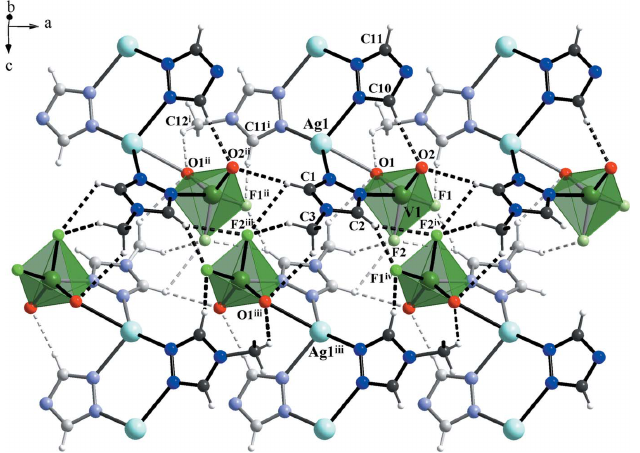
Figure 3 Hydrogen-bonding arrangement in the structure of I showing C—H (cid:2)(cid:2)(cid:2) O and C—H (cid:2)(cid:2)(cid:2) F contacts [symmetry codes: (ii) x (cid:3) 1, y , z ; (iii) (cid:3) x , (cid:3) y + 1, (cid:3) z + 1; (iv) (cid:3) x + 1, (cid:3) y + 1, (cid:3) z + 1; (v) (cid:3) x + 1, (cid:3) y + 1, (cid:3) z ; (vi) x , (cid:3) y + 3 z (cid:3) 1 .]. Phenyl groups are omitted for 2